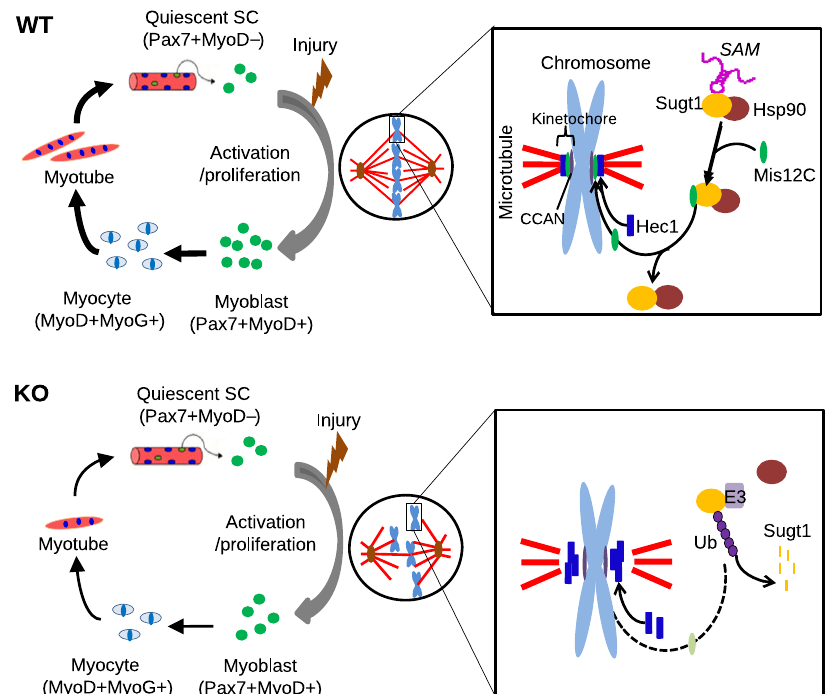
Fig. 7 Schematic model depicting the functional role of SAM during SC activation/proliferation. In WT mice, SAM regulates SCs proliferation by binding with co-chaperon protein Sugt1 to facilitate the kinetochore assembly during mitosis, thereby governing the fi delity of cell division. In KO mice, loss of SAM induces degradation of Sugt1 by ubiquitination then disrupts kinetochore assembly in mitotic cells due to mislocalization of Dsn1 and Hec1, delays proliferation and impairs muscle regeneration after acute or chronic muscle